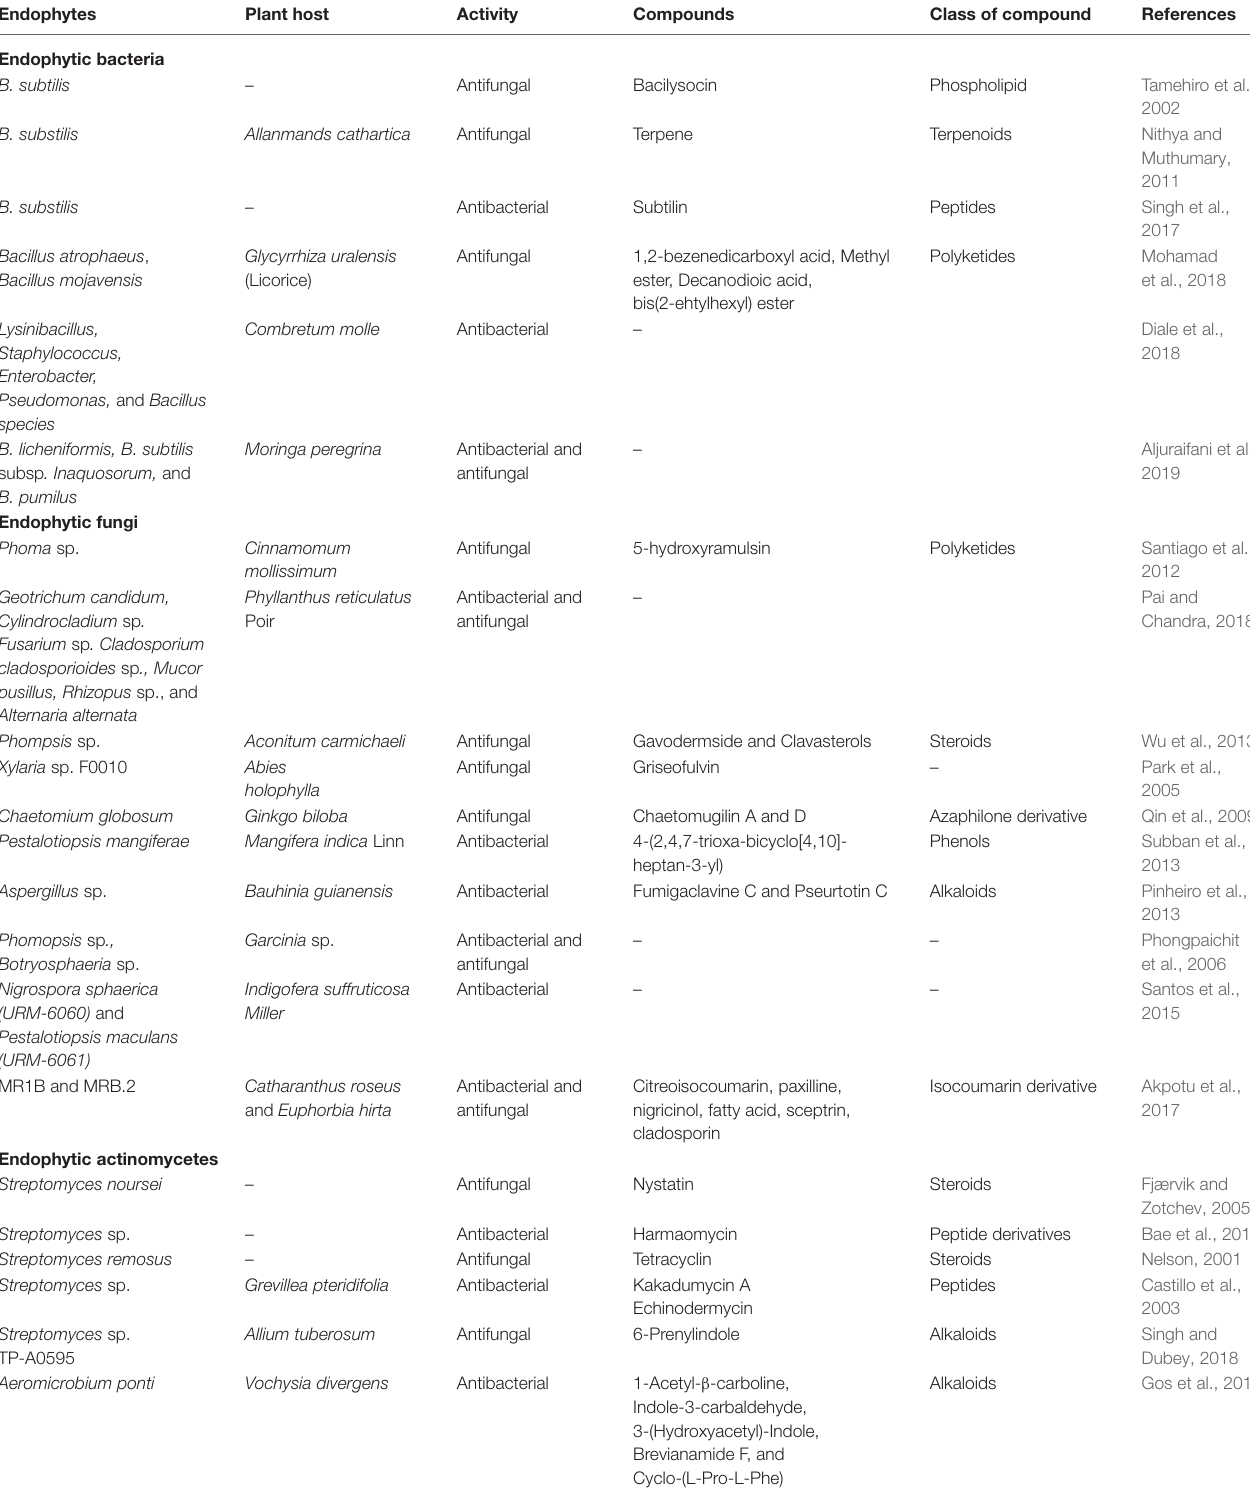
TABLE 1 | Summary of studies on the antimicrobial activities of